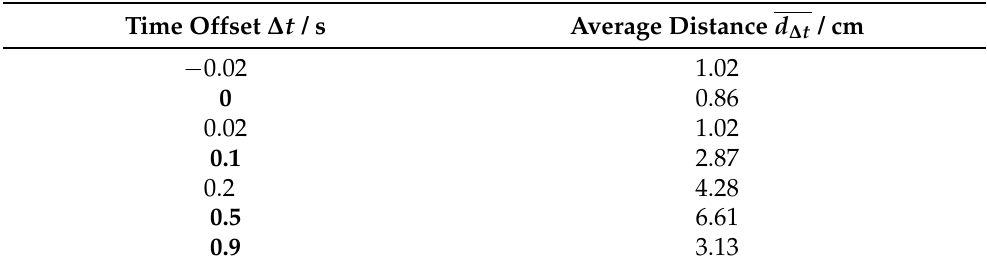
Table 1. Average distance d ∆ t between the fused trajectory and the camera trajectory in the xy - plane for a given time offset ∆ t from the synchronous time. For the bold offset, the corresponding trajectories are shown in Figure